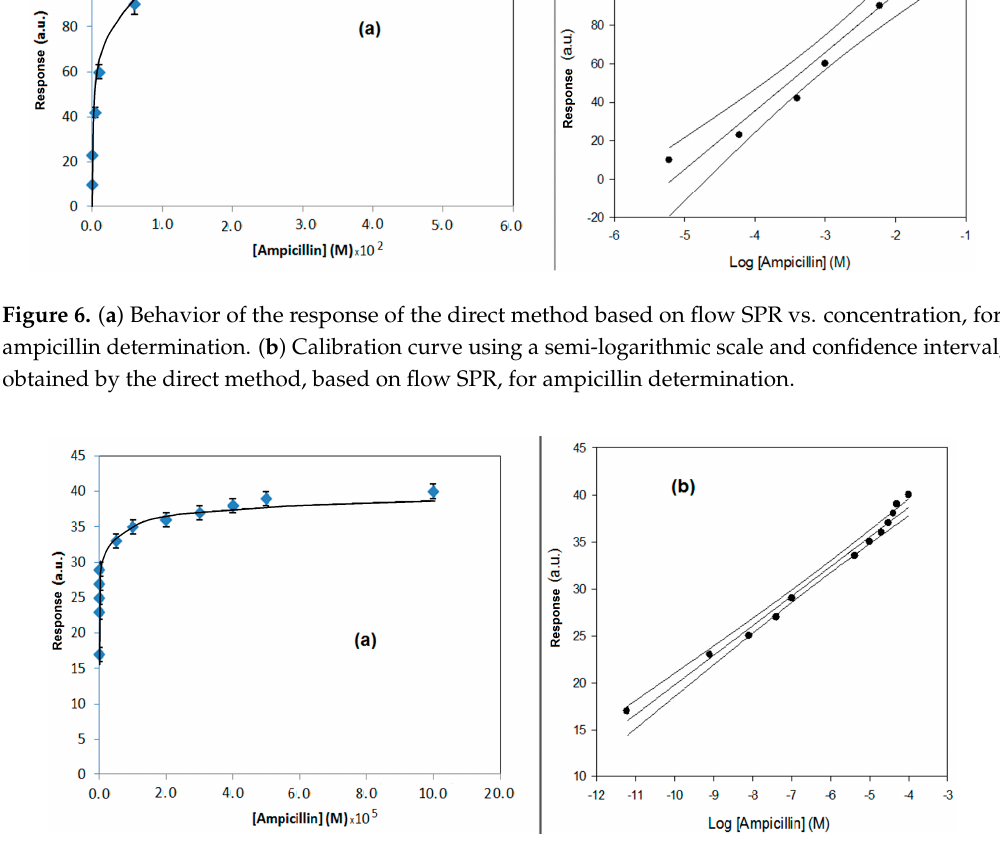
Figure 7. ( a ) Behavior of the conventional amperometric immunosensor response using the competitive format as a function of increasing ampicillin concentration; H 2 O 2 electrode as transducer and peroxidase enzyme as marker. ( b ) Calibration curve for the conventional amperometric immunosensor and confidence interval using the competitive format for ampicillin determination obtained using a semilogarithmic scale. Table 1. The main analytical data found using two immunosensors for the determination of ampicillin.